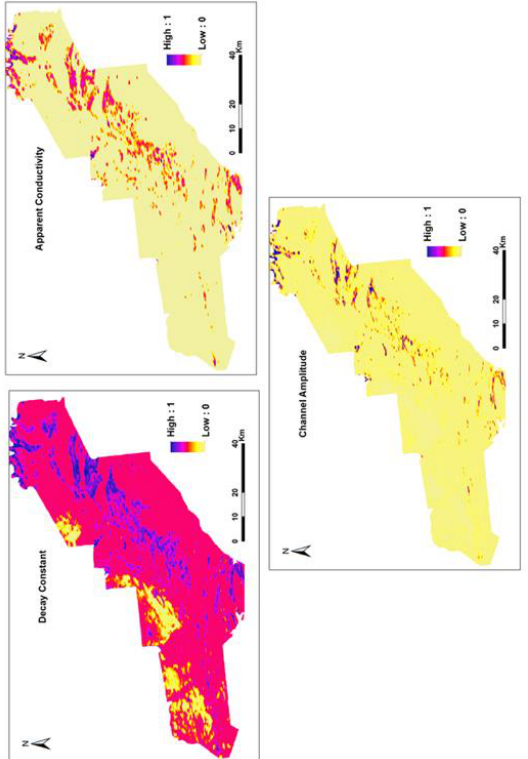
Figure 10. Evidential layers from remote sensing data.